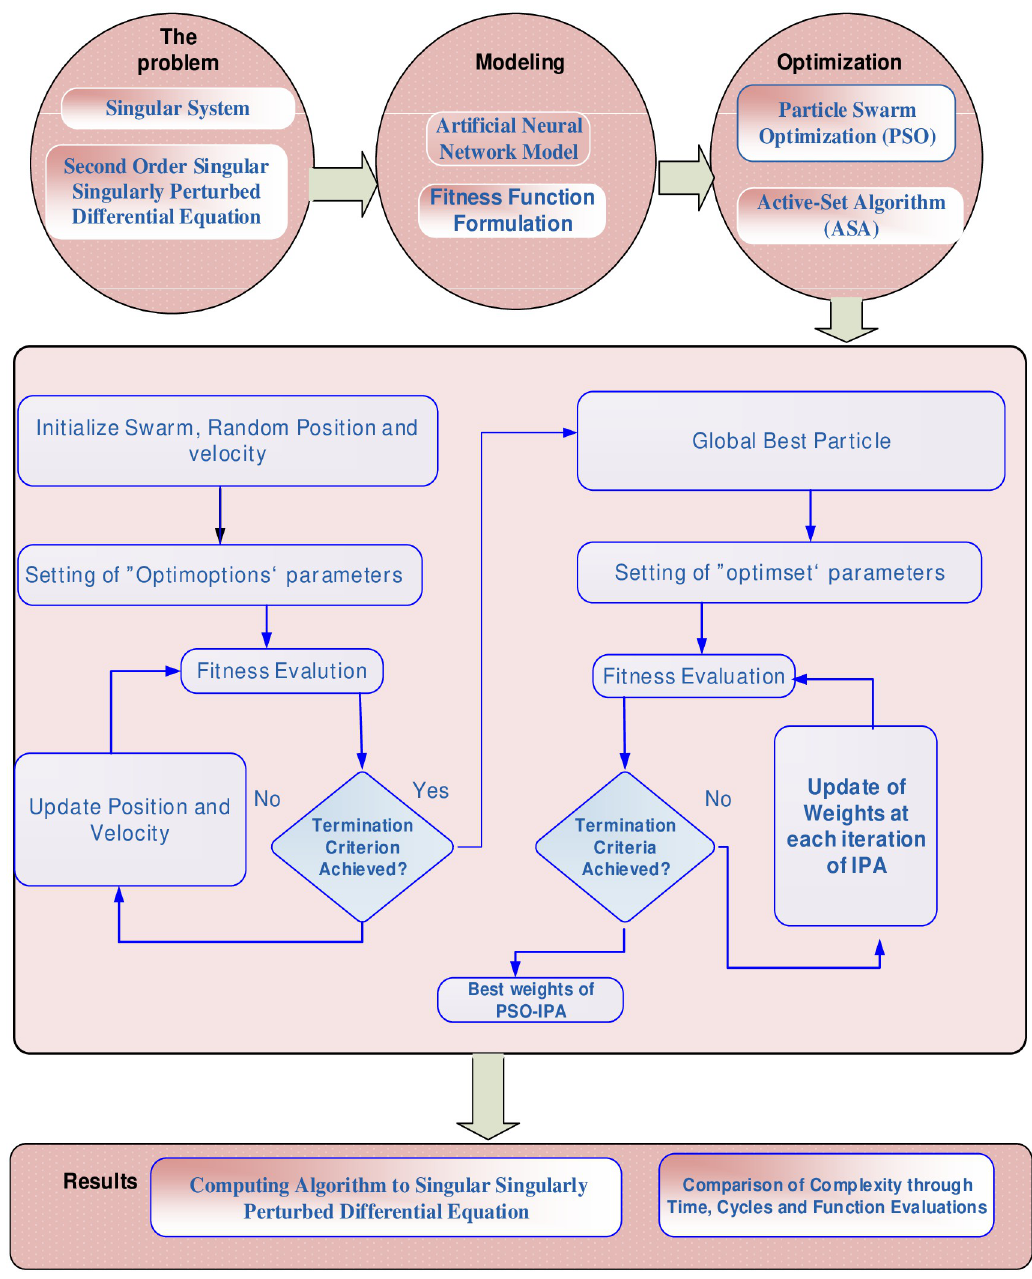
Fig 1. Graphical abstract of suggested scheme for